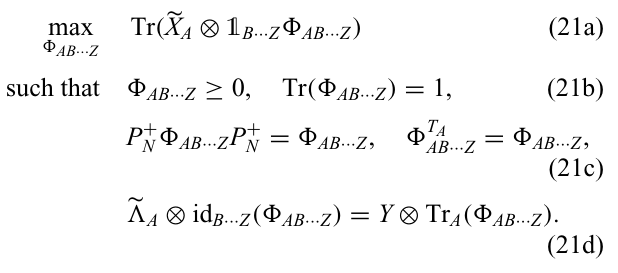
FIG. 2. An illustration of the N -party extension (cid:5) AB ··· Z . Here H = C n is the n -dimensional Hilbert space on which the rank- 1 constrained optimization is defined; H 2 = C k is the k -dimension auxiliary Hilbert space that is used for purifying the rank- k (more precisely, rank no larger than k ) states in H 1 = C n . Sometimes, ⊗ H ⊗ · · · ⊗ H we also denote H ⊗ N as H A B 1 Z 1 in order to dis- 1 1 tinguish the Hilbert spaces H 1 for different parties (similarly for H ⊗ N